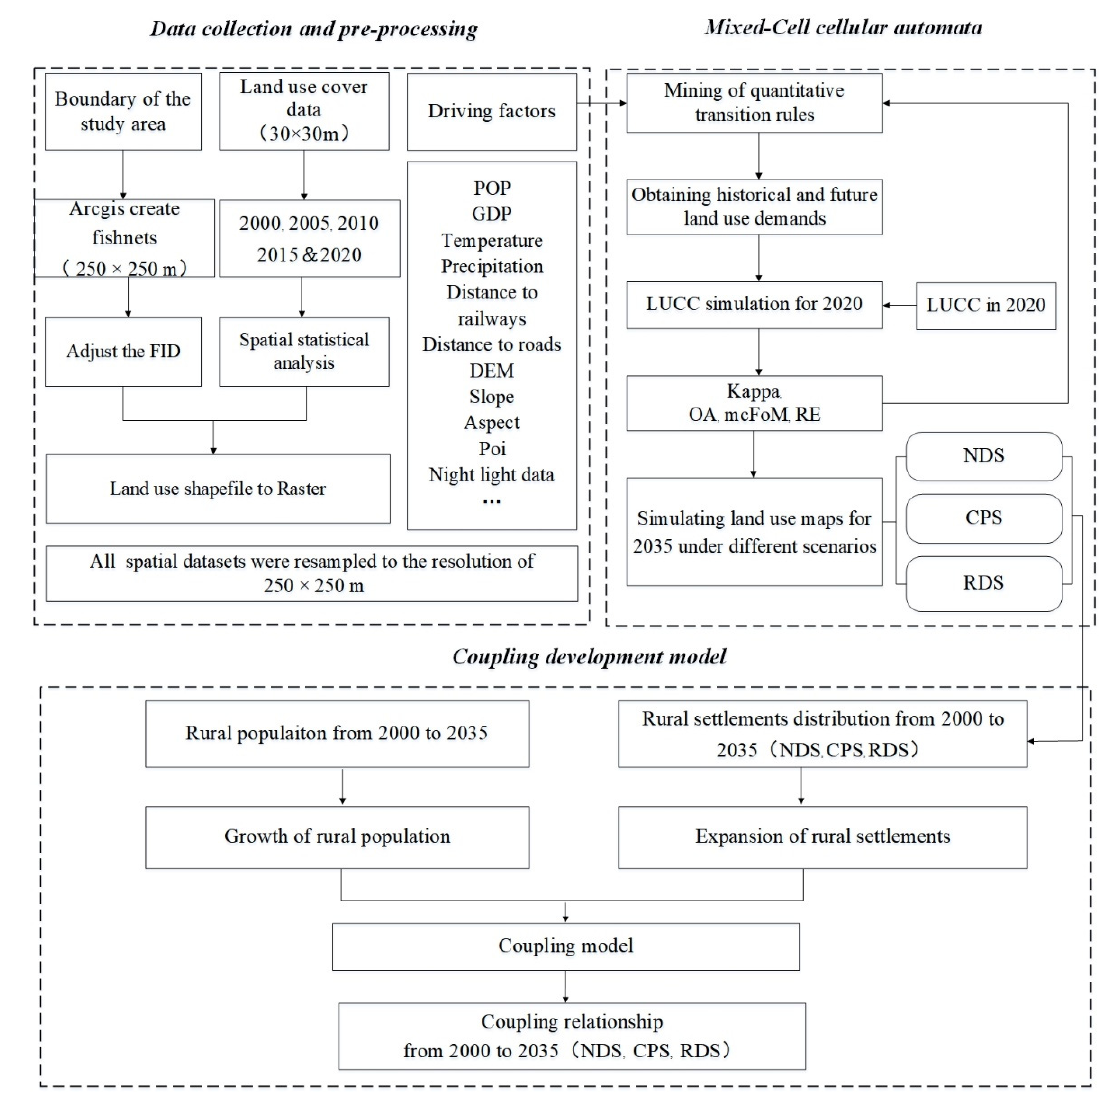
Figure 2. Research framework.